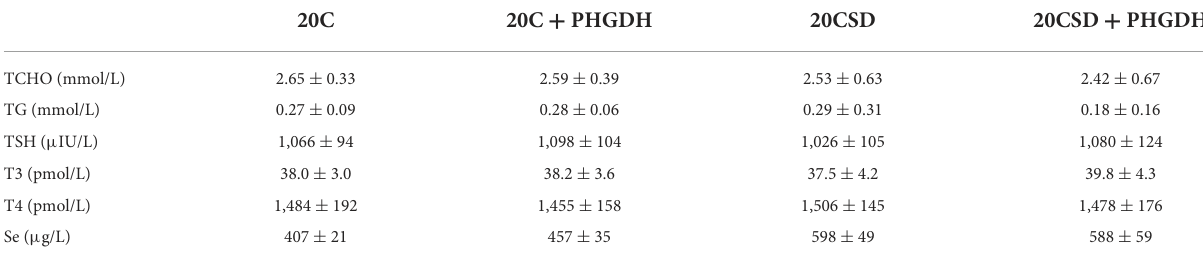
TABLE 4 Effects of PHGDH inhibitor and serine deficiency on plasma TCHO concentration and other variables in pregnant rats fed 20% casein diets (experiment 2).